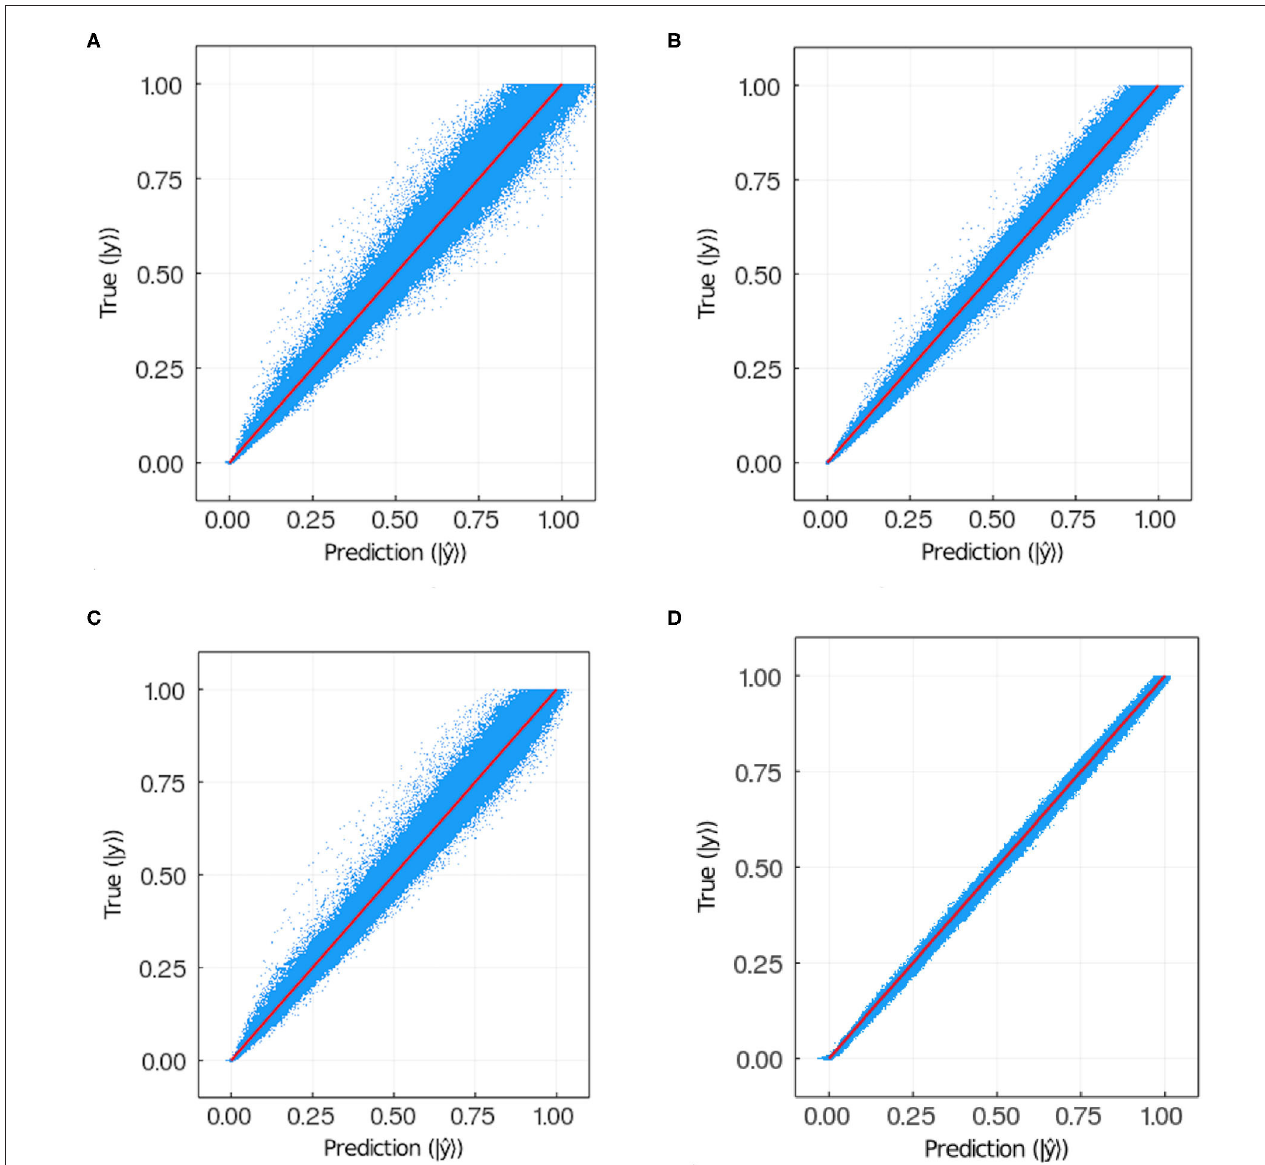
FIGURE 8 | Ground truth vs. prediction for (A) test set and (B) training set in the case of model 9; (C) test set and (D) training set in the case of model 11 (see Table 2 ). The number of points plotted in each panel is 3.75